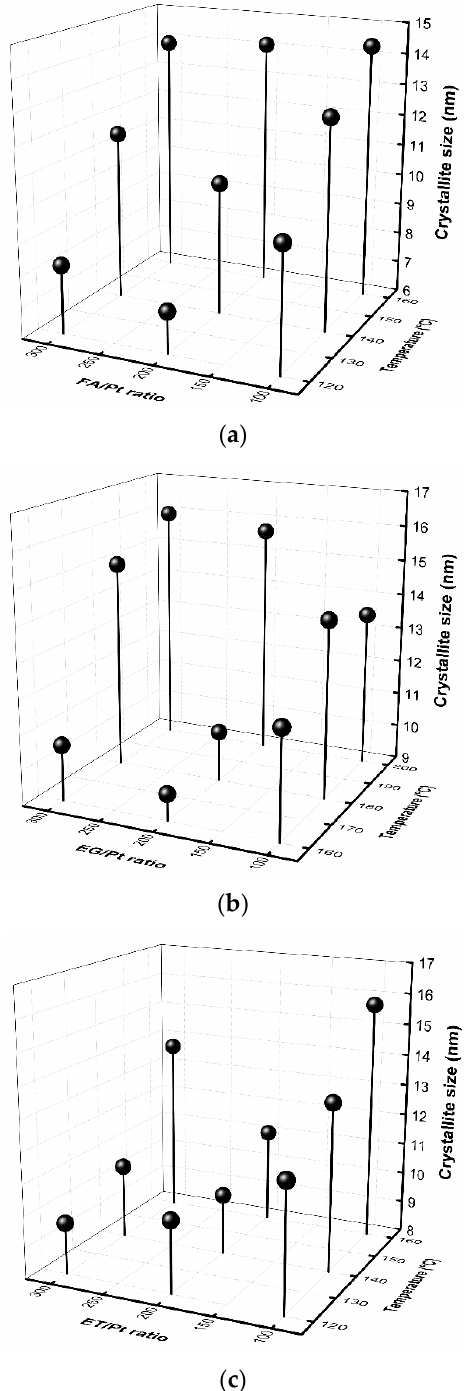
Figure 2. Average crystallite size of the Pt@DL electrodes prepared with different reducing agents under different concentrations and temperatures during the hydrothermal treatment: ( a ) FA; ( b ) EG; ( c ) EG.